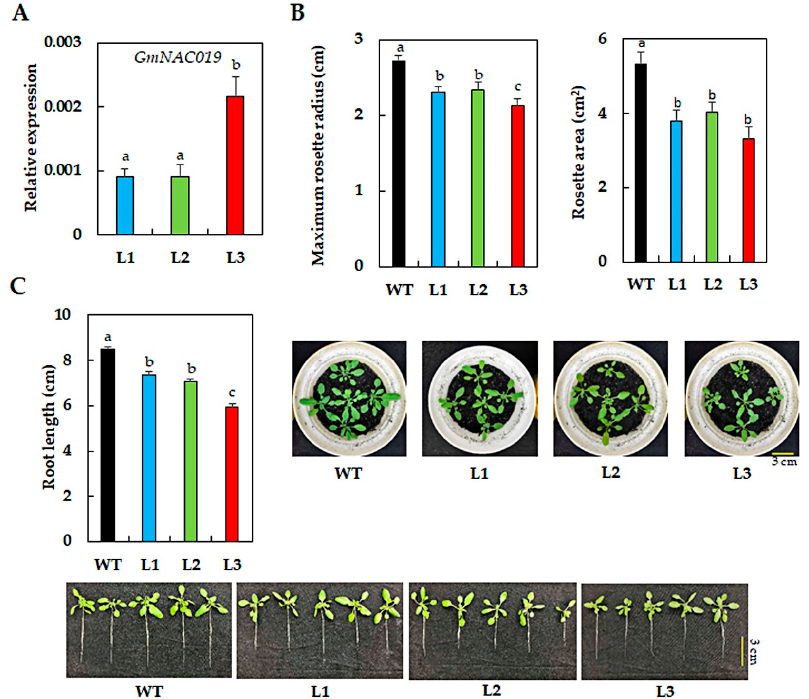
Figure 1. Phenotypes of three transgenic Arabidopsis lines (L1, L2 and L3) carrying 35S:GmNAC019 under normal conditions. ( A ) Relative expression of GmNAC019 detected in the transgenic lines but not wild-type (WT) plants using rosette leaves ( n = 3). ( B ) Maximum rosette radius and average rosette area ( n = 10) with illustrated photographs. ( C ) Average tap root length ( n = 10). Four-week-old plants were used in the examination. Error bars represent SEs. Di ff erent letters indicate significant di ff erences ( p -value < 0.05) among the genotypes, as analyzed by a Duncan’s multiple range